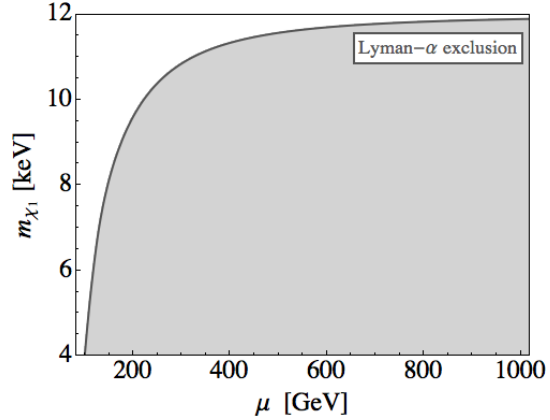
Figure 5 . Bound on the DM mass from Lyman- (cid:11) ; the area below the curve is